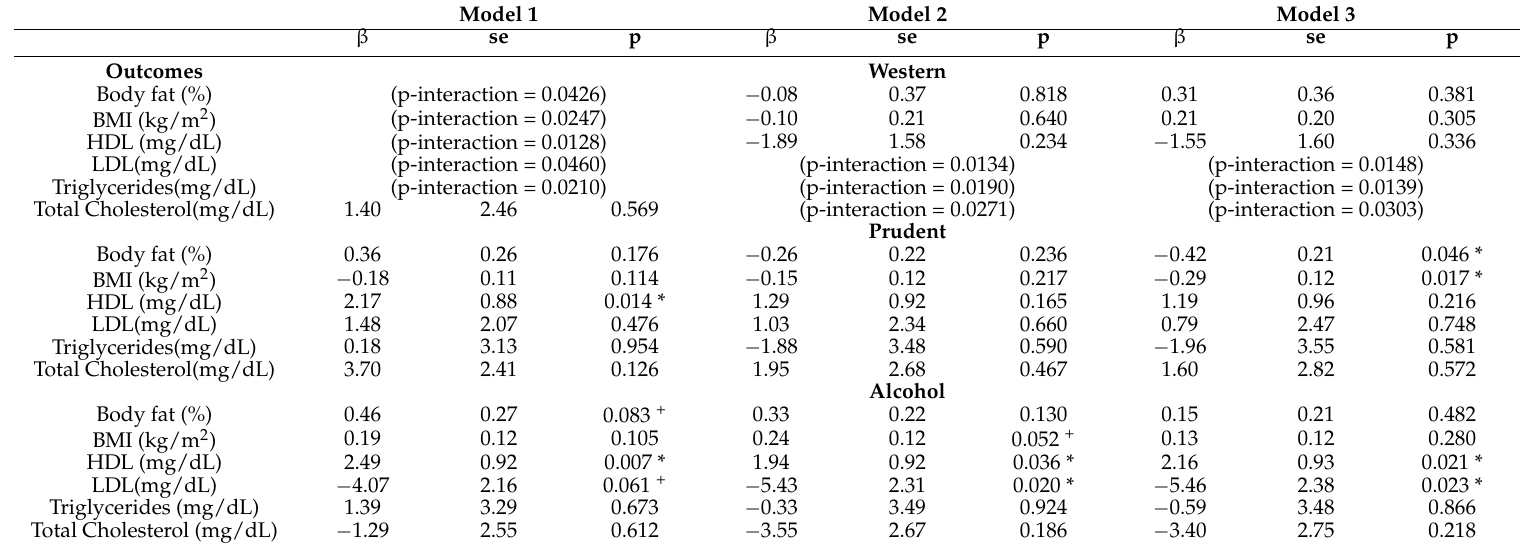
Table 4. Associations between dietary pattern scores and anthropometric and biomarker outcomes.